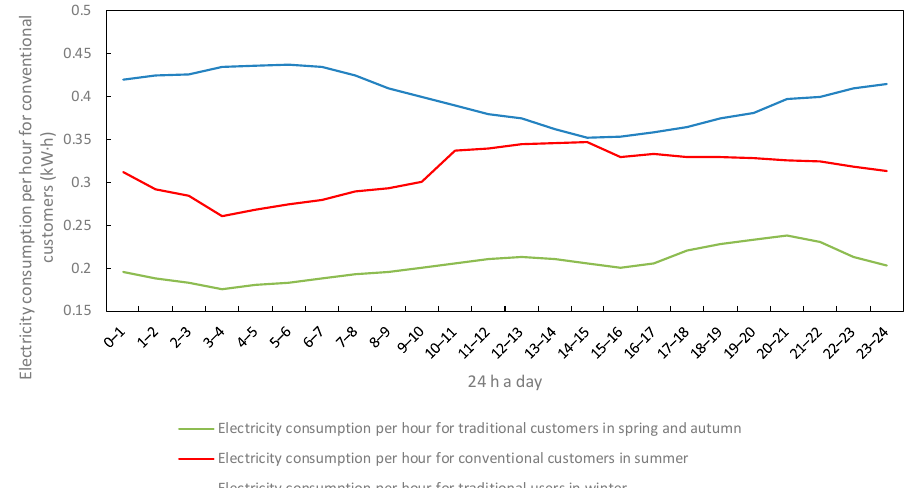
Figure 8. Change in electricity consumption of traditional load users.